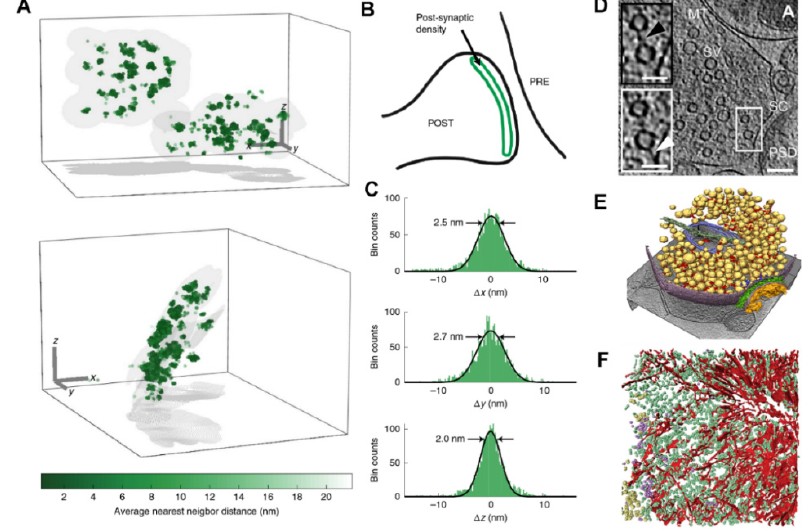
Figure 5. Study of neuronal architecture by maximally informative luminescence excitation (MINFLUX) and cryo-electron tomography (cryo-ET). ( A ), MINFLUX images of the post-synaptic scaffold protein PSD95. The color maps indicate the 3D density of the molecules. The gray areas are curved surfaces on which the molecules lie. The molecules were directly bound to a chemical fluorophore. ( B ), Theoretical organization of the molecule. ( C ), Histograms of localization precision for the molecules shown in panel A, indicating an overall precision of 2.0–2.7 nm. Reproduced from [89]. ( D ) Tomographic slice showing presynaptic short filaments that link synaptic vesicles to each other (“connectors”; black arrowhead in top inset) or to the active zone (“tethers”; white arrowhead in bottom inset). The insets show the same vesicles on different tomographic slices. MT: microtubule, PSD: postsynaptic density, SC: synaptic cleft, SV: synaptic vesicle. Scale bars: 100 nm main panel, 50 nm insets. ( E ) 3D segmentation of a presynaptic terminal showing synaptic vesicles (gold), the presynaptic membrane (purple), densities present in the synaptic cleft (light green), the postsynaptic density (orange), a microtubule (dark green), and a mitochondrion (light blue). Connectors (red) and tethers (blue) were detected automatically [90]. ( D ) and ( E ) are reproduced from [91]. ( F ) 3D segmentation of a neuronal c9orf72 poly-GA aggregate (red) and different macromolecules including ribosomes (yellow), TRiC (purple), and proteasomes (green). Reproduced from [92].